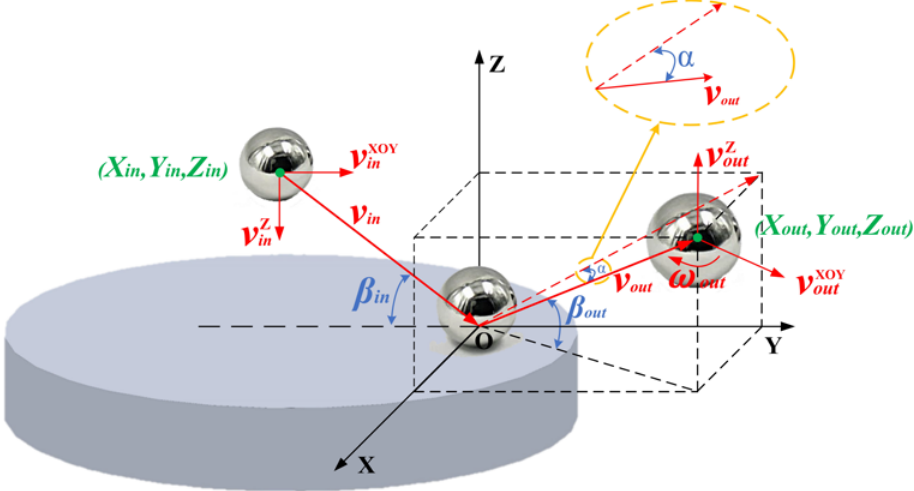
Figure 2. Particle motion parameters.